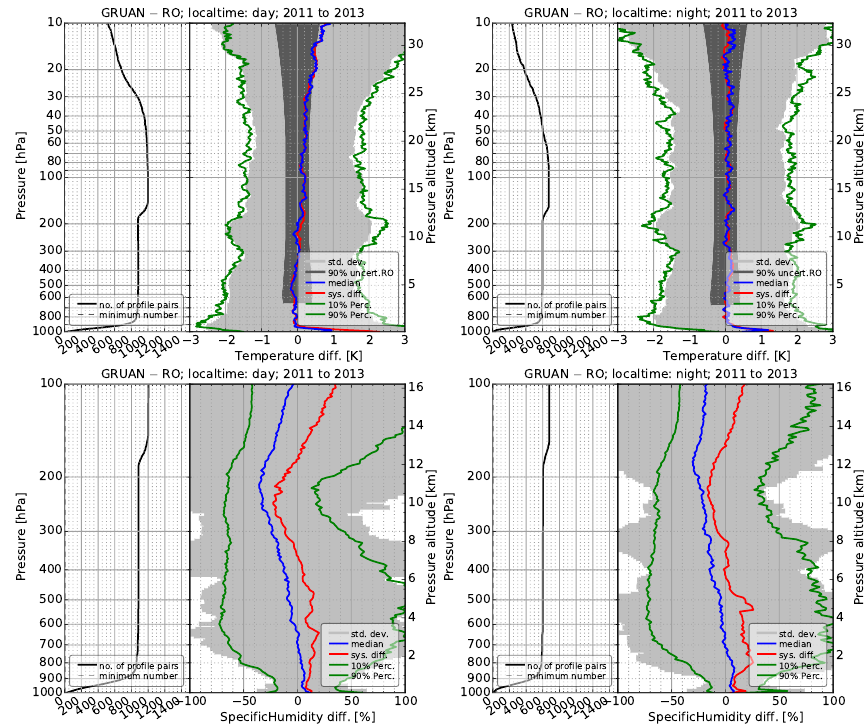
Figure 11. Daytime (left) and nighttime (right) differences as function of pressure/altitude of GRUAN versus GPSRO, for temperature (top) and specific humidity